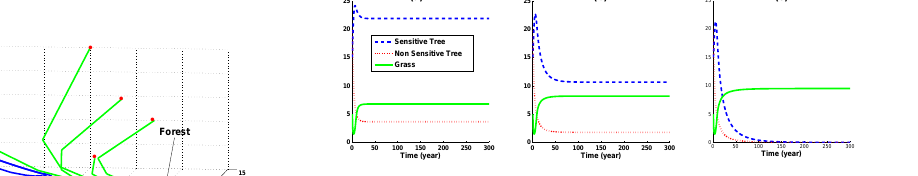
Fig. 4. From savanna to grassland as a function of the grass vs. sensitive-tree competition parameter σ G . From left to right, is fixed, while the grass vs. sensitive-tree the fire period τ = 1 f competition parameter σ G increases. In (a) ( τ = 5 , σ G = 0), in (b) ( τ = 5 , σ G = 0 . 02) and in (c) ( τ = 5 , σ G = 0 . 04)